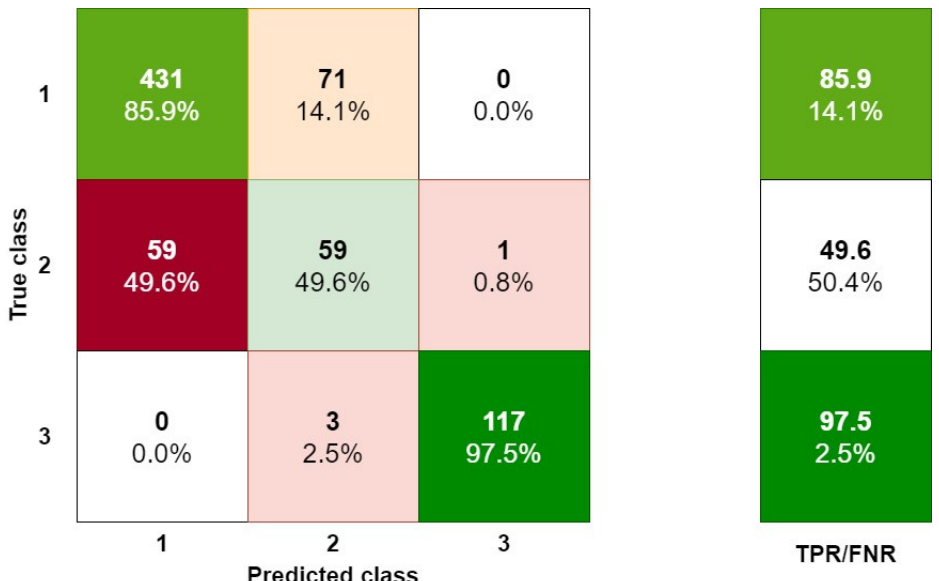
Figure 8. Confusion matrix for the decision tree.